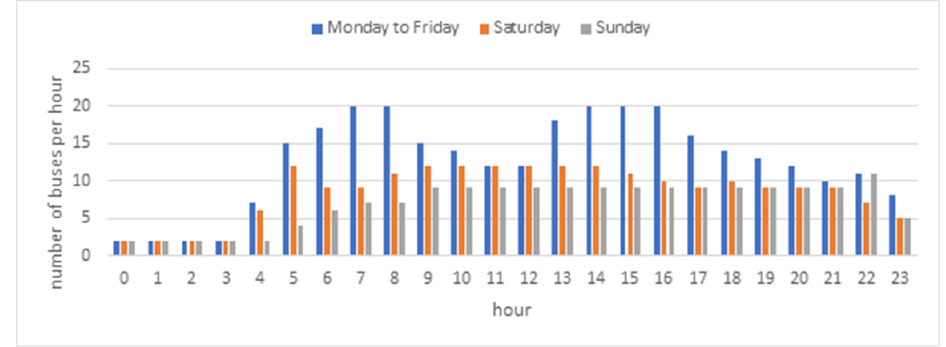
Figure 3. Local bus frequency in the analysed section of the road network. Source: own elaboration based on MPK-Łódź timetables.